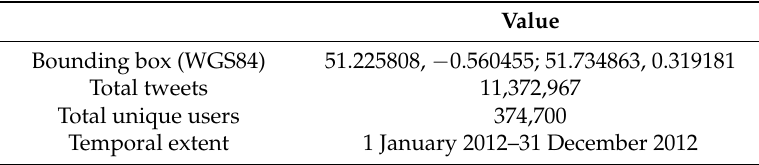
Table 1. General overview of the Twitter data set.